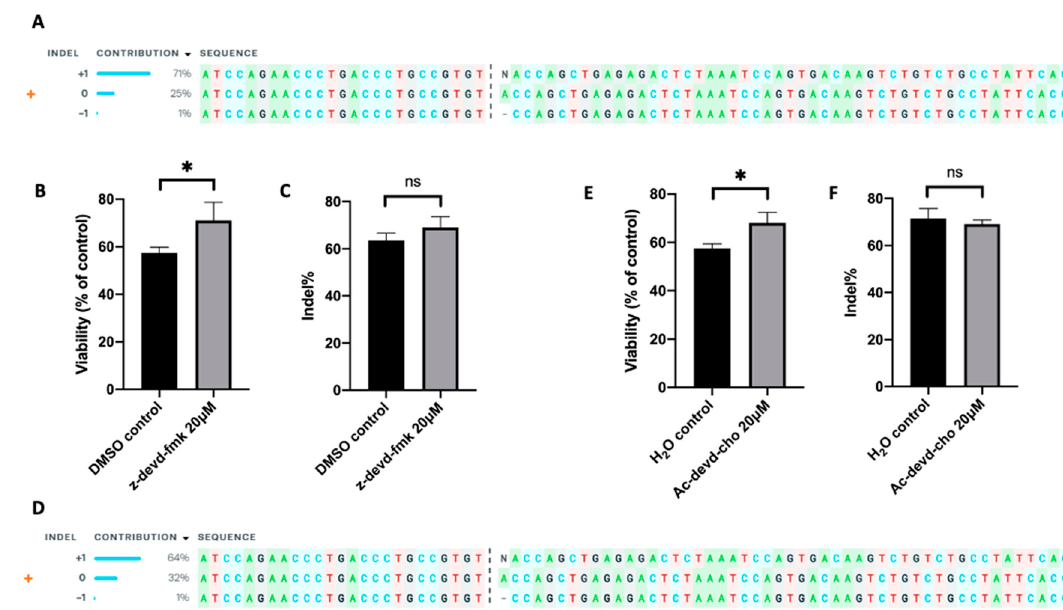
Figure 9. Effects of apoptosis inhibition on cell viability and indel frequency in human primary T cells. The gene-editing was achieved through electrotransfer of an RNP targeting the TRAC gene. ( A – C ) Apoptosis was inhibited with z-devd-fmk treatment; ( D – F ) apoptosis was inhibited with Ac-devd-cho treatment. ( A , D ) ICE analysis, showing the outcome of TRAC editing in T cells; ( B , E ) cell viability measured at 24 h post pulsing; ( C , F ) Indel within TRAC gene determined at 48 h post pulsing using TIDE analysis. Pulsing condition: 650 V / 0.2 cm, 300 µ s, 2 pulses, 10 Hz. ns, non-significant. Error bars, SEM; * p < 0.05, Student’s t -test, N = 4.